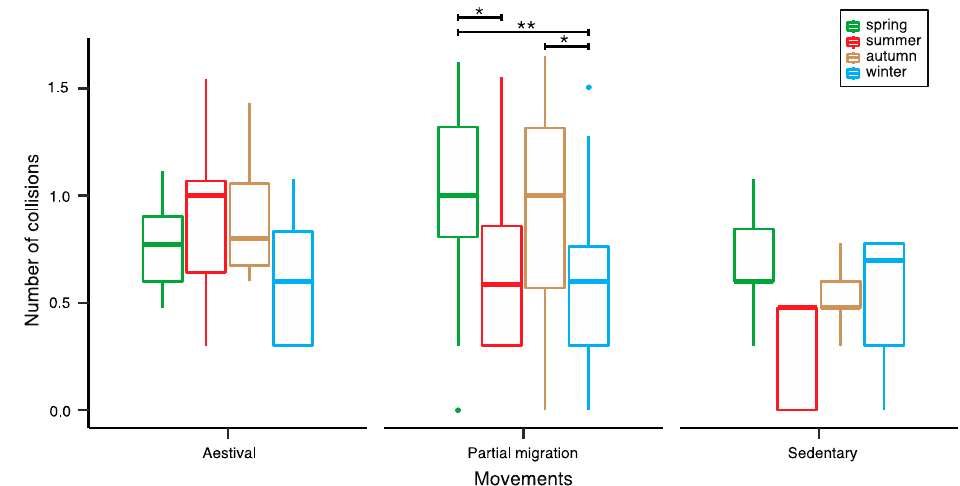
Figure 4. Depiction of repeated measures ANOVA assessing the number of collisions through the year (log10 + 1) depending on each species movement. Species sharing movements are displayed using boxplots for each season. Tukey contrasts significance codes are included for relevant pairwise comparisons: ‘**’ 0.01, ‘*’ 0.05.